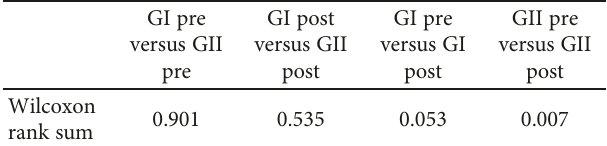
Table 10: Statistical signi fi cance of voice quality analysis ( p